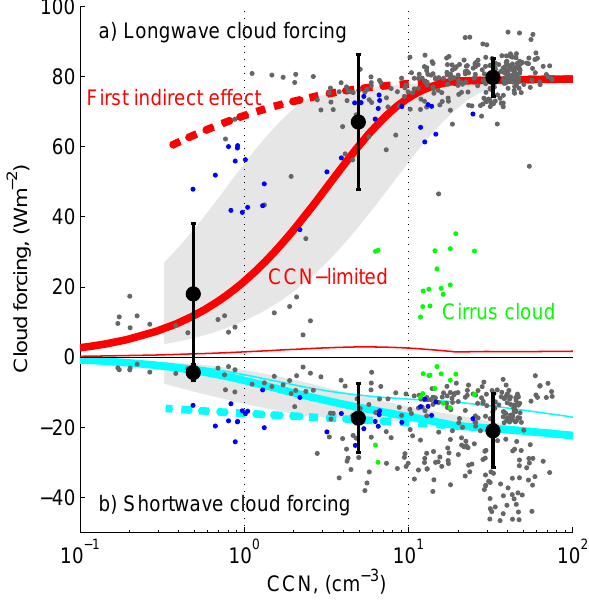
Fig. 2. Surface (a) longwave- and (b) shortwave cloud radiative forcing as a function of CCN number concentration. CCN measurements were made at a supersaturation of 0.2 % . Dots are hourly observations; lines are idealized radiative transfer calculations described in the text. Dashed lines represent the first aerosol indirect effect only. Solid thick lines correspond to cloud liquid content being limited by R e ≤ 15 µ m. The grey shaded areas show the sensitivity to critical R e values between 10 and 30 µ m. Thin solid lines are the long- and shortwave cloud forcing at the top of the atmosphere. Large black dots are bin averaged values for each decade of CCN concentration and bars indicate the standard deviation from the decade mean. Green markers are related to a single case with mid-tropospheric ice clouds that are radiatively very different from a low-level stratus cloud; furthermore, the CCN concentration measured near the surface is not relevant for these clouds. Blue markers are cases for which the CCN measurement is particularly dependent on the choice of supersaturation. This is due primarily to a steep cumulative size distribution near the critical size for activation at the supersaturation used.